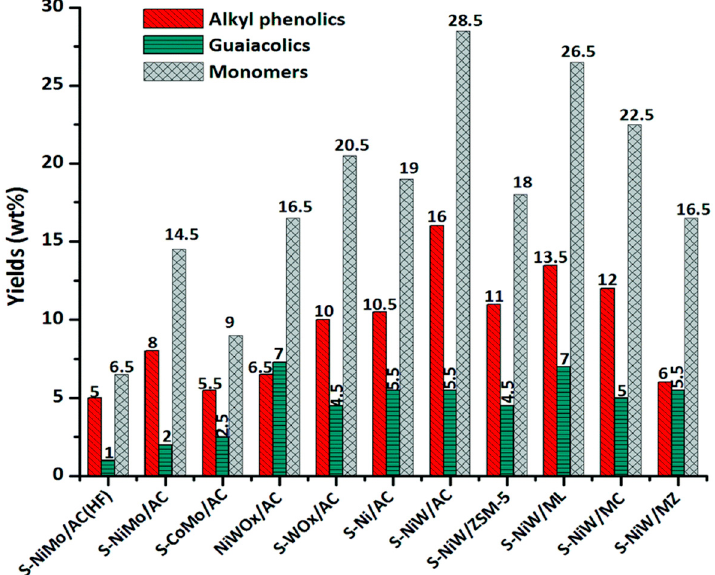
Figure 16. E ff ect of catalysts on alkylphenolics, guaiacolics, and monomer yields Figure 16. Effect of catalysts on alkylphenolics, guaiacolics, and monomer yields [79] .